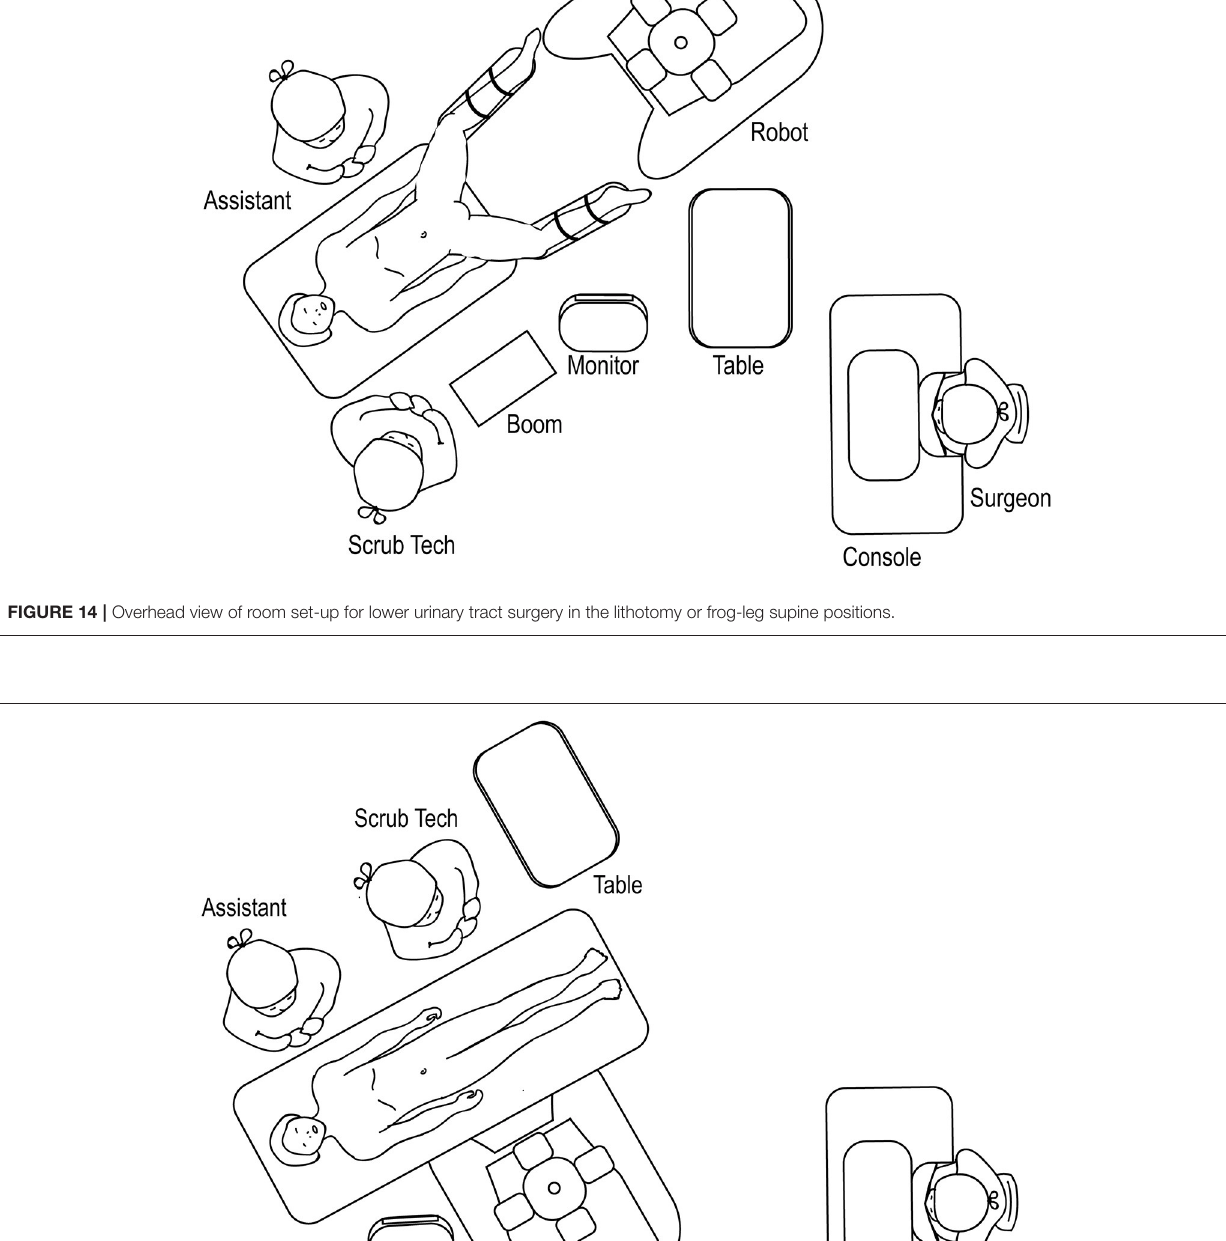
Frontiers in Pediatrics |